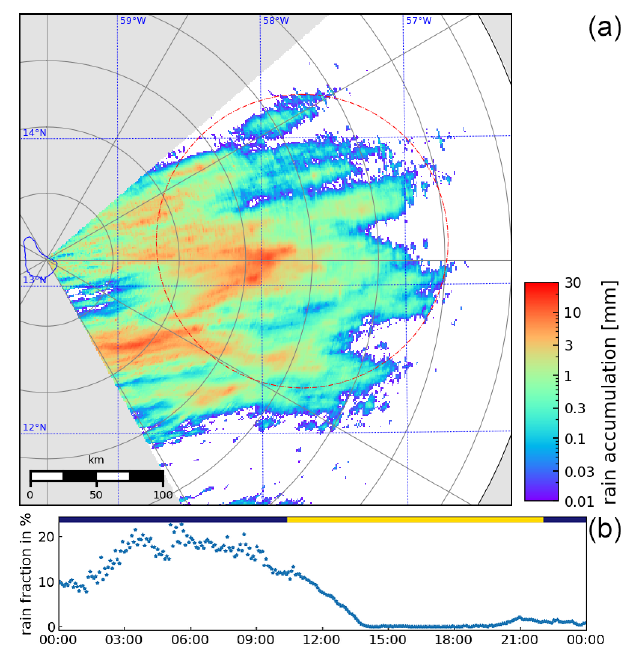
Figure 11. As Fig. 9 for 11 February 2020.